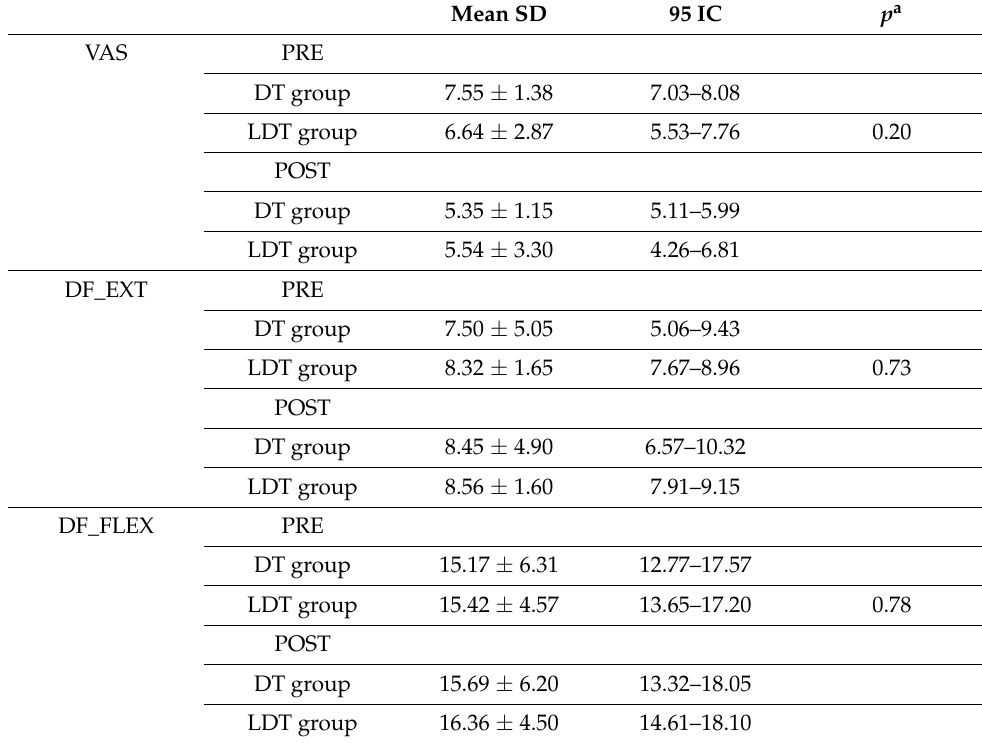
Table 2. Descriptive statistics of